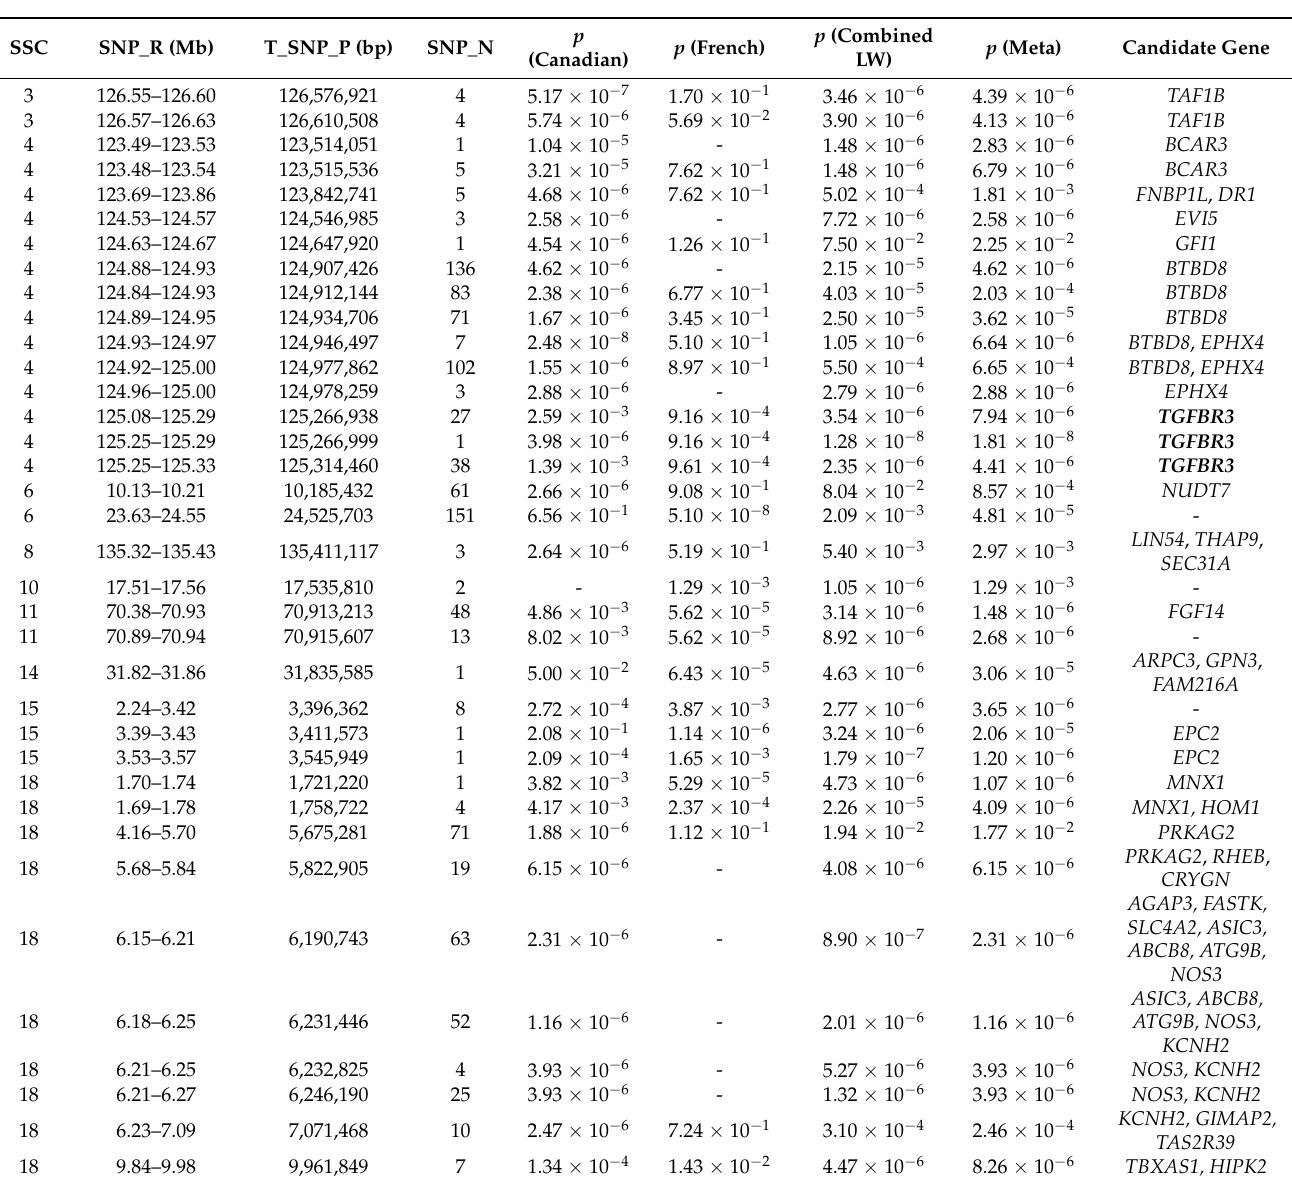
SSC, Sus scrofa chromosome. SNP_R, range of significant and suggestive SNPs region. SNP_N, number of significant and suggestive SNPs. T_SNP_P, the position (bp) of the top SNP in range of significant and suggestive SNPs region. p (Canadian), p -value from within-population GWAS in the Canadian line. p (French), p -value from within-population GWAS in the French line. p (Combined LW), p -value from within-population GWAS in the combined lines of Large White pigs. p (Meta), p -value from cross-population meta-analyses. The bolded text shows the potential candidate gene detected in both chip and WGS data. For the GL trait, the Manhattan plots are shown in Figure 4e–h. The Q-Q plots are shown in Supplementary Figure S4e–h, with genome inflation factors between 0.975 and 1.024 (Supplementary Table S3). For the GWAS analysis within both Large White lines, no genome-wide significant SNPs were detected. Seven SNPs at the suggestive significant level were observed in the Canadian line and 136 SNPs at the suggestive significant level in the French line. In the GWAS analysis of the combined lines of the Large White population, no genome-wide significant SNPs and 156 SNPs at the suggestive significant level were detected. There were 48 SNPs at the suggestive significant level in the cross-population meta-analyses (Table